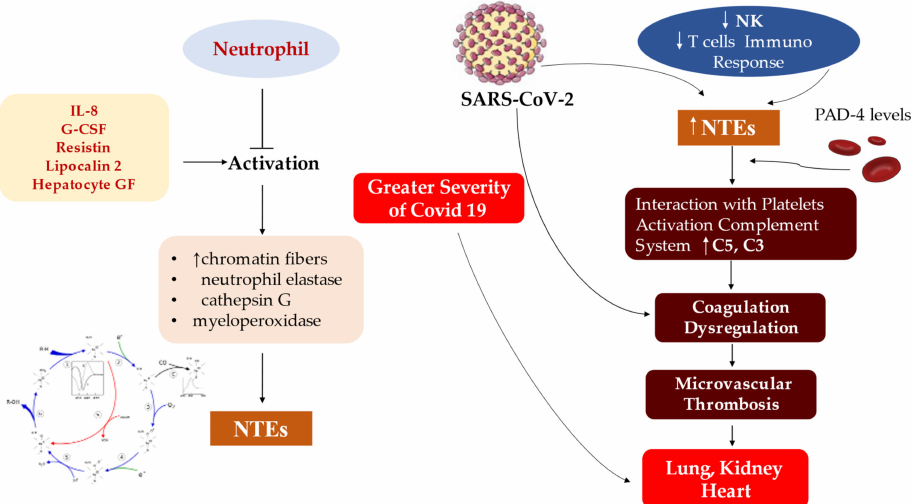
Figure 6. SARS-CoV-2 determines the activation of neutrophils mediated by IL-8, G-CSF, resistin, lipocalin-2, hepatocyte growth factor and NET release. The immune response of NK and T lympho- cytes contributes to the formation of NETs with the increased level of a completement system (C5 and C3). The generated microvascular thrombosis leads to organ damage. Abbreviations: C, complement; GF, grow factor; IL, interleukine; NK; natural killer. Bottom left depict the biochemical reaction for the formation of NETs Other abbreviations in previous figure. ↑ , increase; ↓ ,